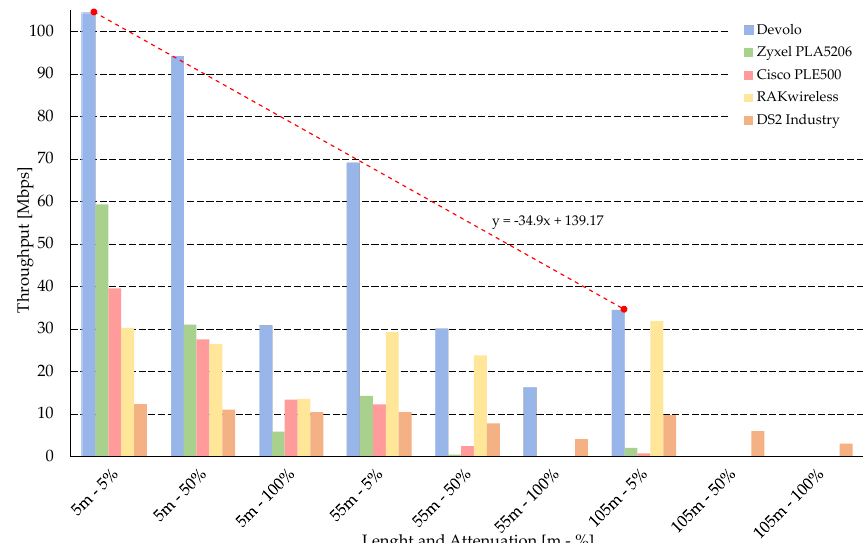
Figure 3. Comparison of RFC 6349–TCP throughput.